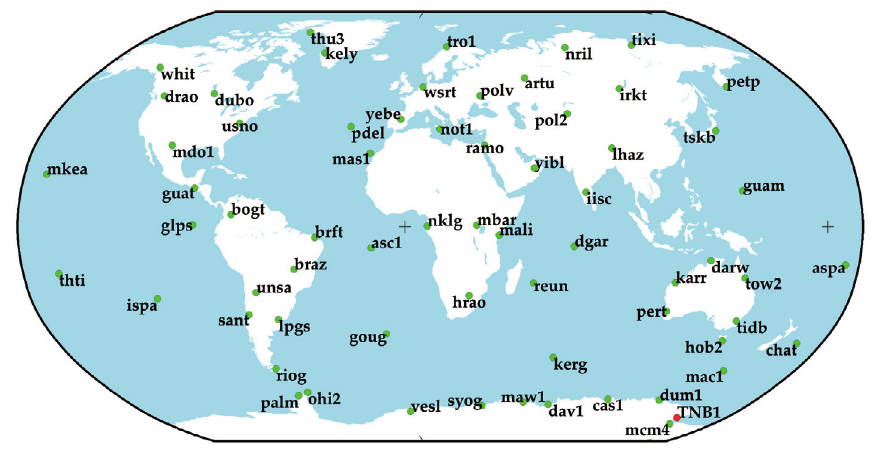
Figure 3. Map showing the distribution of the GPS stations from where the data were used in the analysis described in Section 3.1.